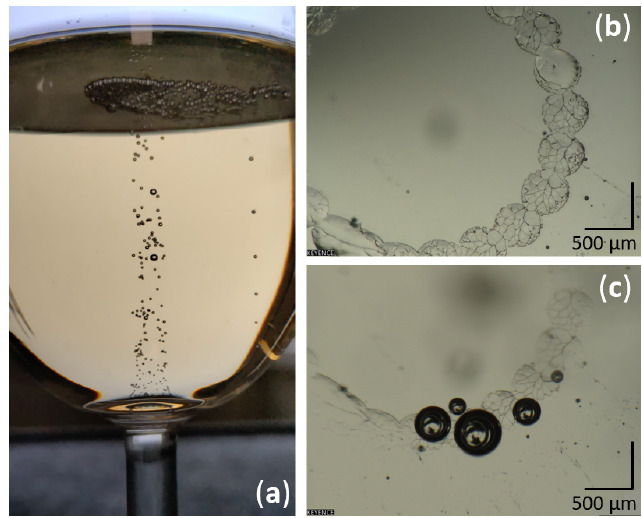
Figure 5. Close-up photograph of the laser-etched INAO glass containing 100 mL of champagne and releasing bubbles through non-classical heterogenous bubble nucleation ( a ); micrograph of the ring-shaped laser etches as observed through optical microscopy (Keyence) of an empty glass ( b ) and in a glass containing with champagne with bubble nucleation captured ( c ).